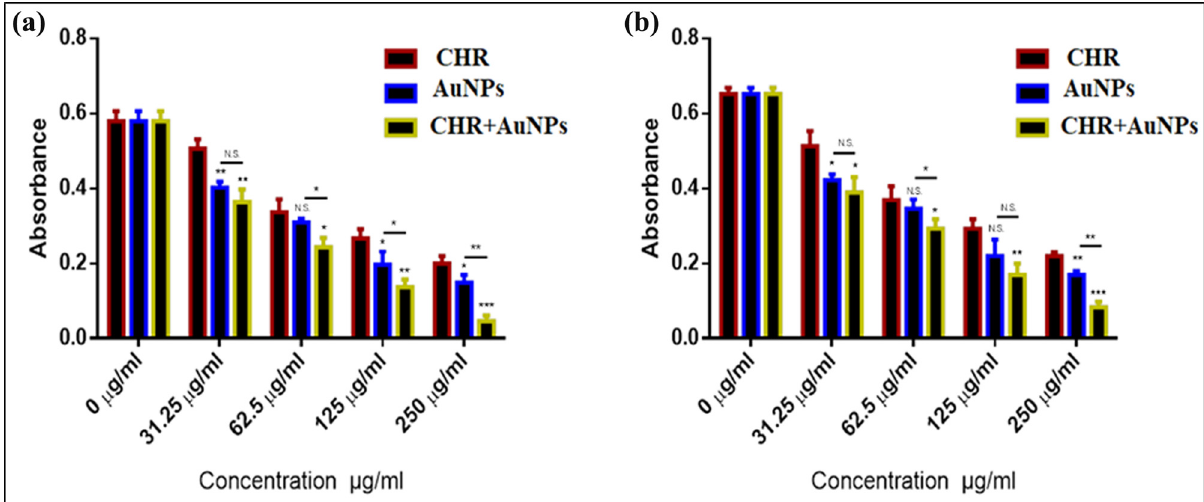
Figure 11: Anti - microbial activity: CHR, AuNPs, and CHR – AuNPs anti - microbial activity against ( a ) S. aureus , ( b ) E. coli. The values represent mean ± s.d.; n = 3, N.S., non - signi fi cant, * P < 0.05, ** P < 0.01, and *** P < 0.001.